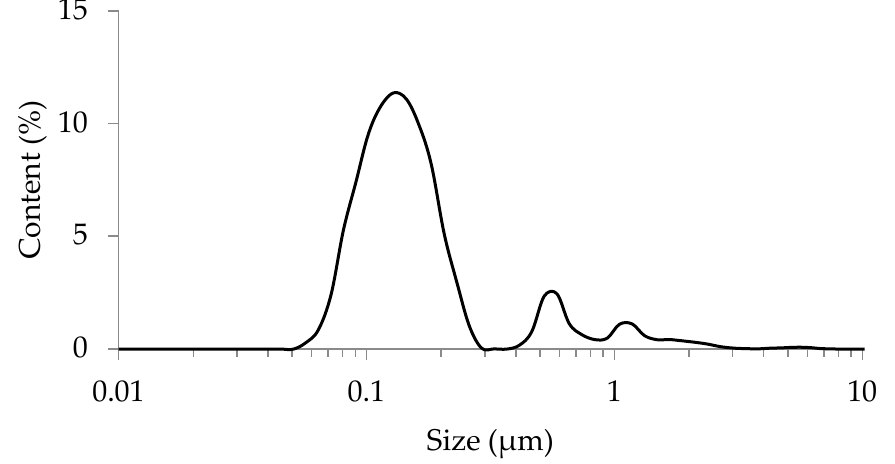
Figure 1. Particle size distribution of a separated clay fraction of road dust.